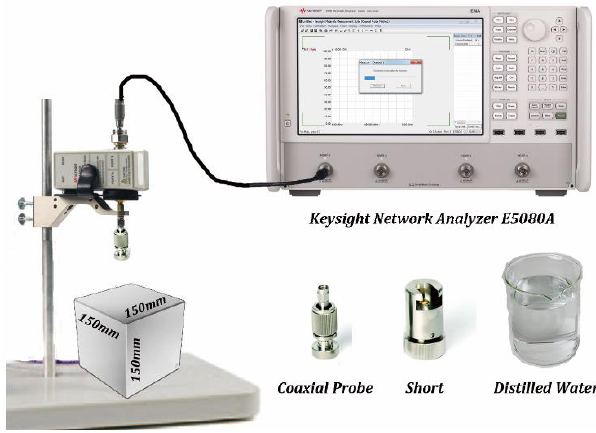
Figure 3. Experimental setup of dielectric constant measurement.